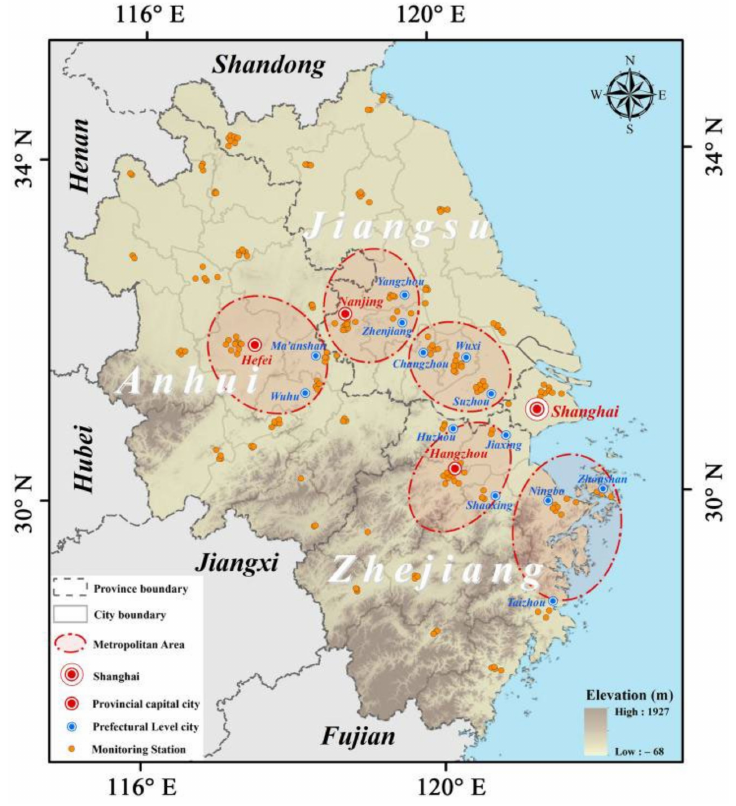
Figure 1. Overview of the study